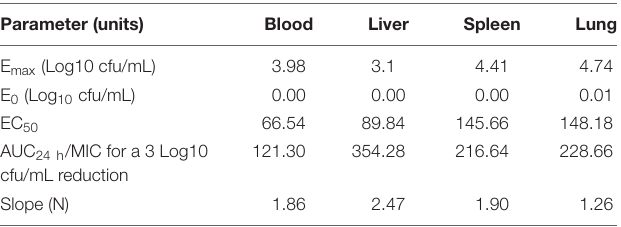
TABLE 2 | Pharmacodynamic analysis of danofloxacin in infected rabbits targeting the blood, liver, spleen, and lung. Parameter (units) Blood Liver Spleen